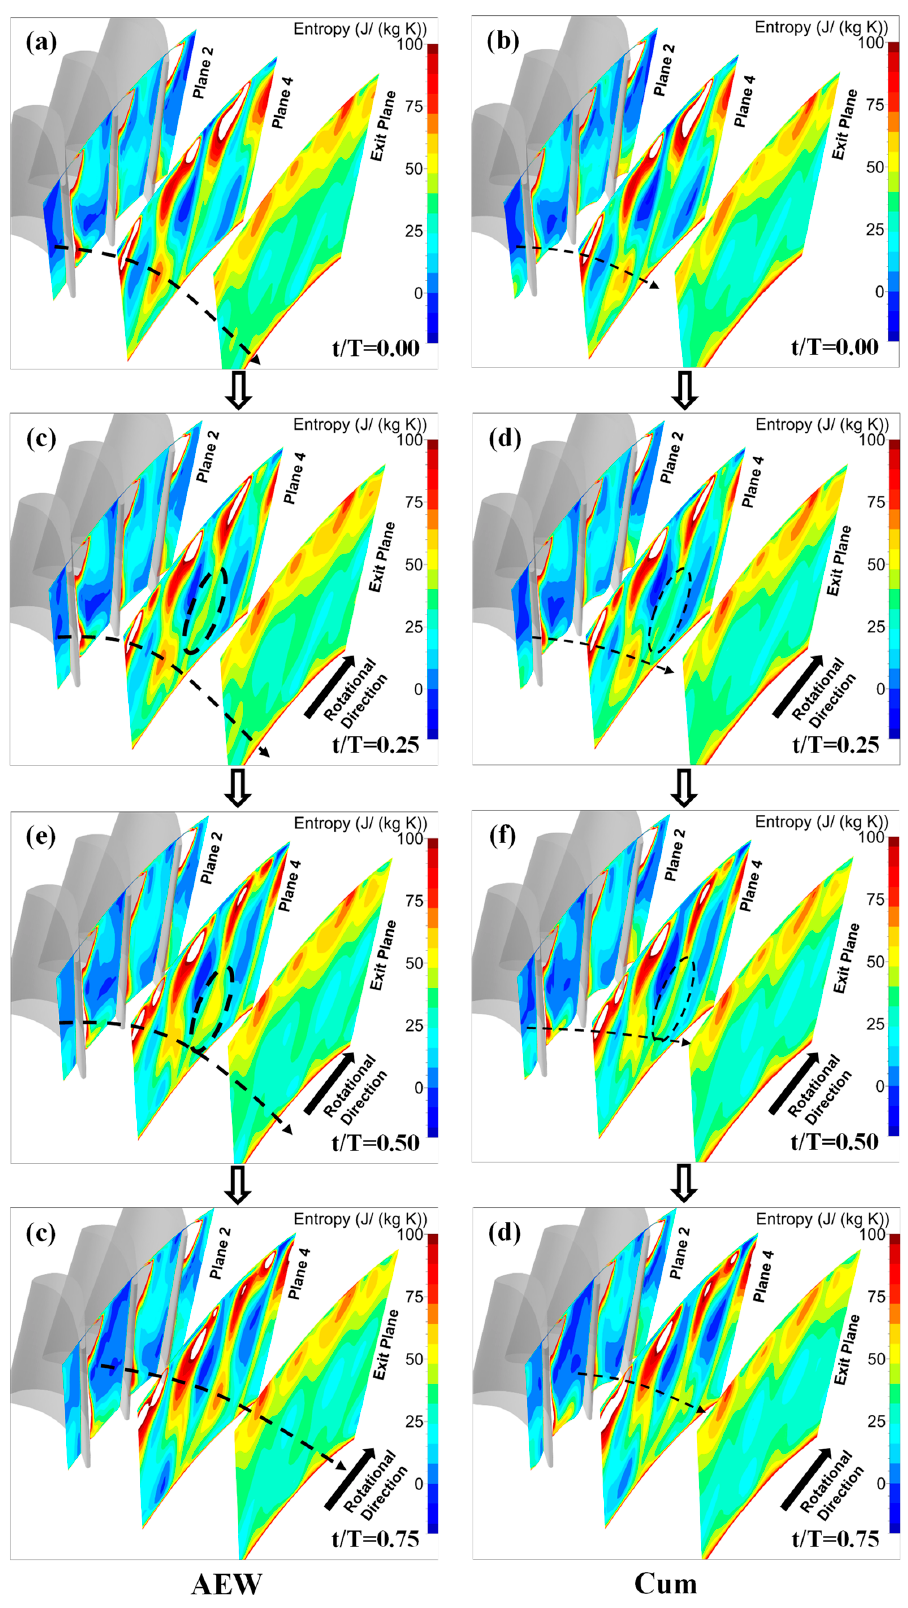
Figure 20. ( a – f ) Time-resolved entropy contours at three di ff erent planes downstream of the Figure 20. Time-resolved entropy contours at three different planes downstream of the rotor.